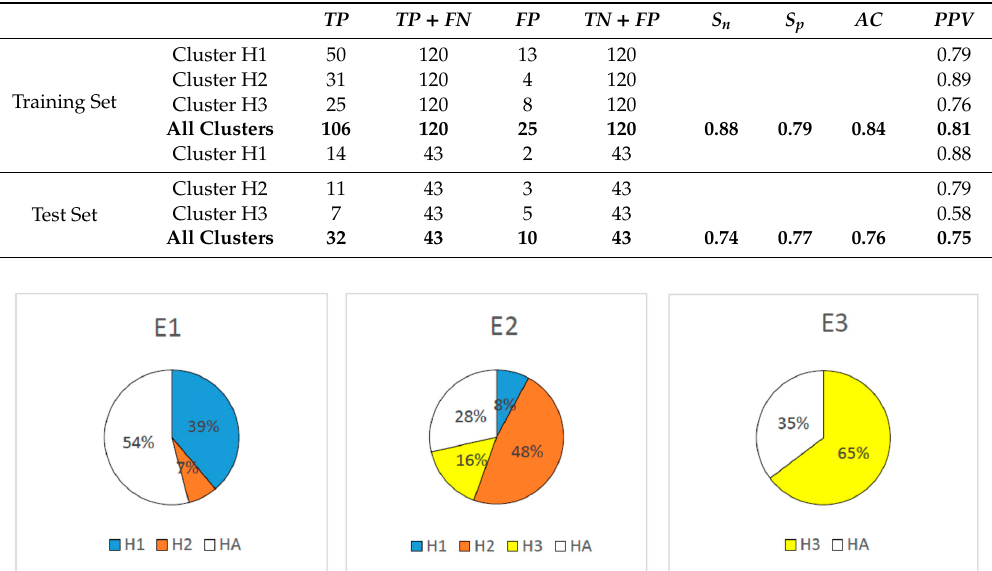
Figure 2. Distribution of peptides, active against Escherichia coli ATCC 25922 by clusters established for non-hemolytic peptides. E1, E2, and E3—clusters revealed for peptides, active against Escherichia coli ATCC 25922 ; H1, H2, H3—clusters revealed for non-hemolytic peptides; HA—array of peptides which do not belong to the non-hemolytic clusters.